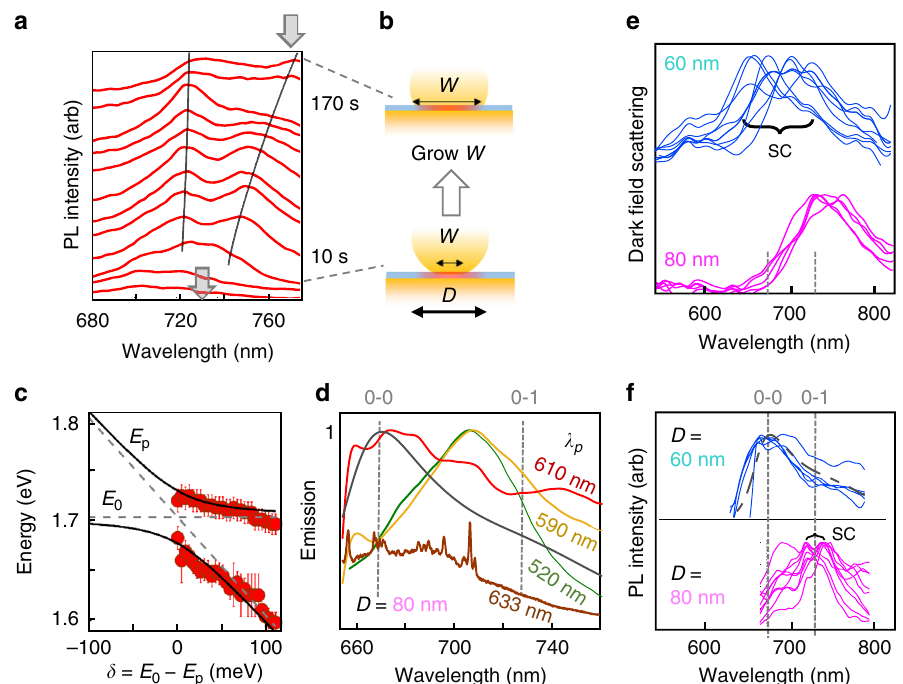
Fig. 3 Time dependent emission. a Time evolution of emission spectrum of single Atto647 molecule inside plasmonic nanocavity. Spectra (offset) are at times 5, 15, 25, 55, 65, 70, 80, 90, 105, 120, 150 s, gray arrows show DF position at start and end (color map shown in Supplementary Fig. 4). b Schematic facet increase with time, which redshifts cavity plasmon. c Peak energies versus detuning δ = E 0 − E p between plasmon ( E p ) and dye ( E 0 ) resonances. Lines are fi ts to Rabi coupling model. The error bar is the uncertainty of the fi t to the peaks in Fig. 3a. d PL emission spectra for 120 fs excitation of single Atto647 molecules in D = 80 nm NPoM, for pump wavelengths of 520, 590, 610 nm, as well as CW excitation at 633 nm (showing SERS peaks), and CW PL spectra of dye in solution (gray dashed). e Dark- fi eld scattering and ( f ) PL emission from NPoM constructs of different NP diameter, tuning the plasmon into resonance with (d) absorption or (e) emission to give strong coupling